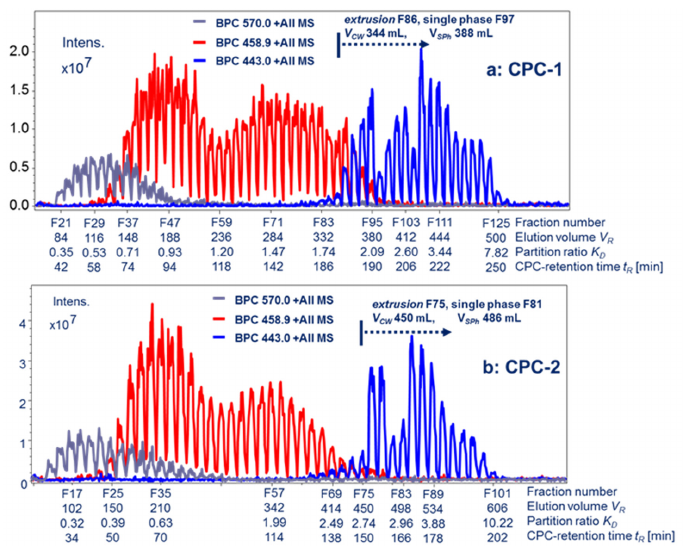
Figure 3. Metabolite visualization of semi-preparative CPC fractionations (CPC-1 and CPC-2) of white tea extract by off-line ESI-MS/MS analysis of fractions in the sequence of recovery, visualizing co-elution effects by use of selected single ion traces (ESI-MS positive mode, scan range m/z 100– 2000). Detected target mass values for R-/S -EGCG-cThea ( m/z 570), ECGC and GCG ( m/z 459; EGCG eluted earlier than GCG), and ECG ( m/z 443) as [M + H] + signals. ( a ) CPC-1 experiment (inj.: 500 mg) operated in the elution/ extrusion -mode (flow: 2.0 mL/min) with HEMWat (1:5:1:5, v / v / v / v ), extrusion - mode at switch volume V CW (344 mL), velocity 1000 rpm, corrected stationary phase retention S F 89.5%, corrected stationary phase V S 179 mL (calculations cf. Supplementary Material, Data/Equations). ( b ) CPC-2 experiment (inj.: 500 mg) operated in the elution/extrusion-mode (flow: 3.0 mL/min) with HEAWat (0.7:3:1.3:5, v / v / v / v ), extrusion-mode at switch volume V CW (450 mL), velocity 1000 rpm, corrected stationary phase retention S F 76.0%, corrected stationary phase V S 144 mL (calculations cf. Supplementary Material).